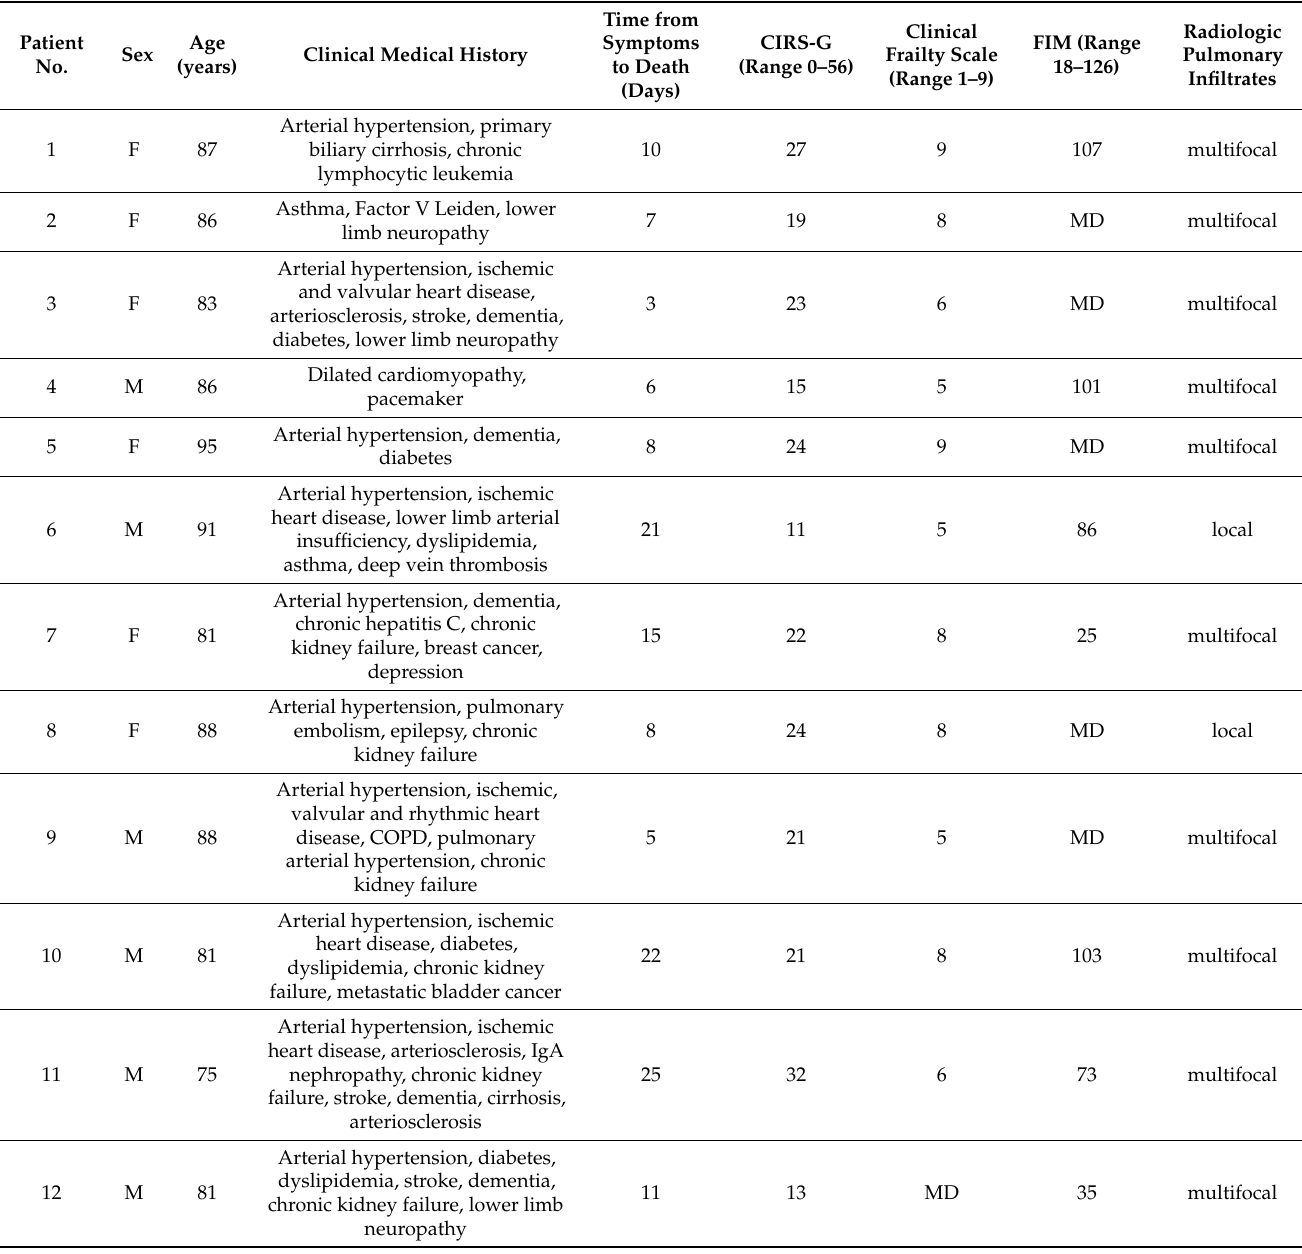
Table 1. Clinical characteristics of the 12